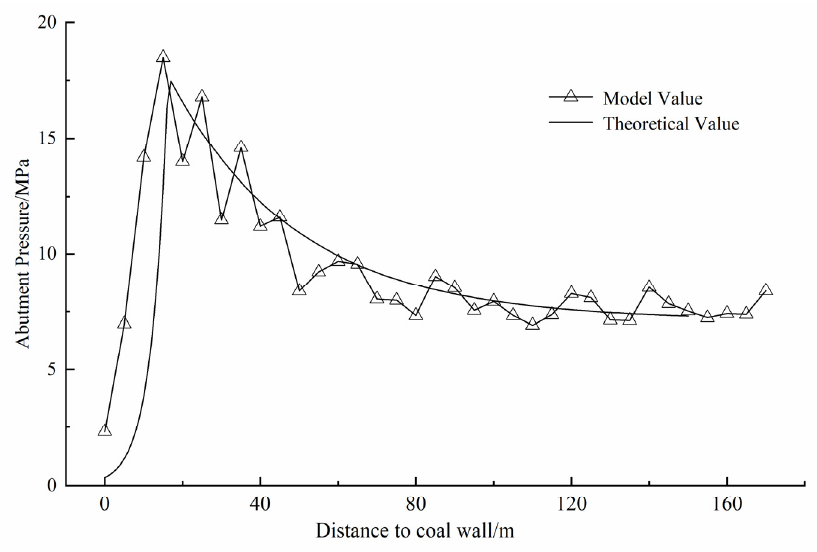
Figure 6. The distribution of abutment pressure ahead of the working face.